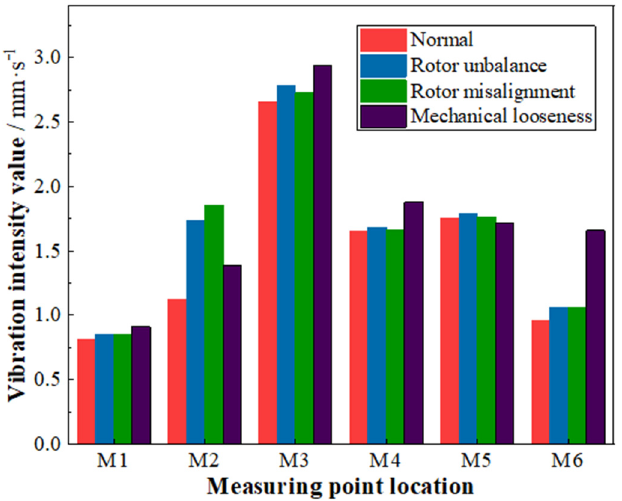
Figure 3. Comparison of vibration intensity of each measuring point under different states .